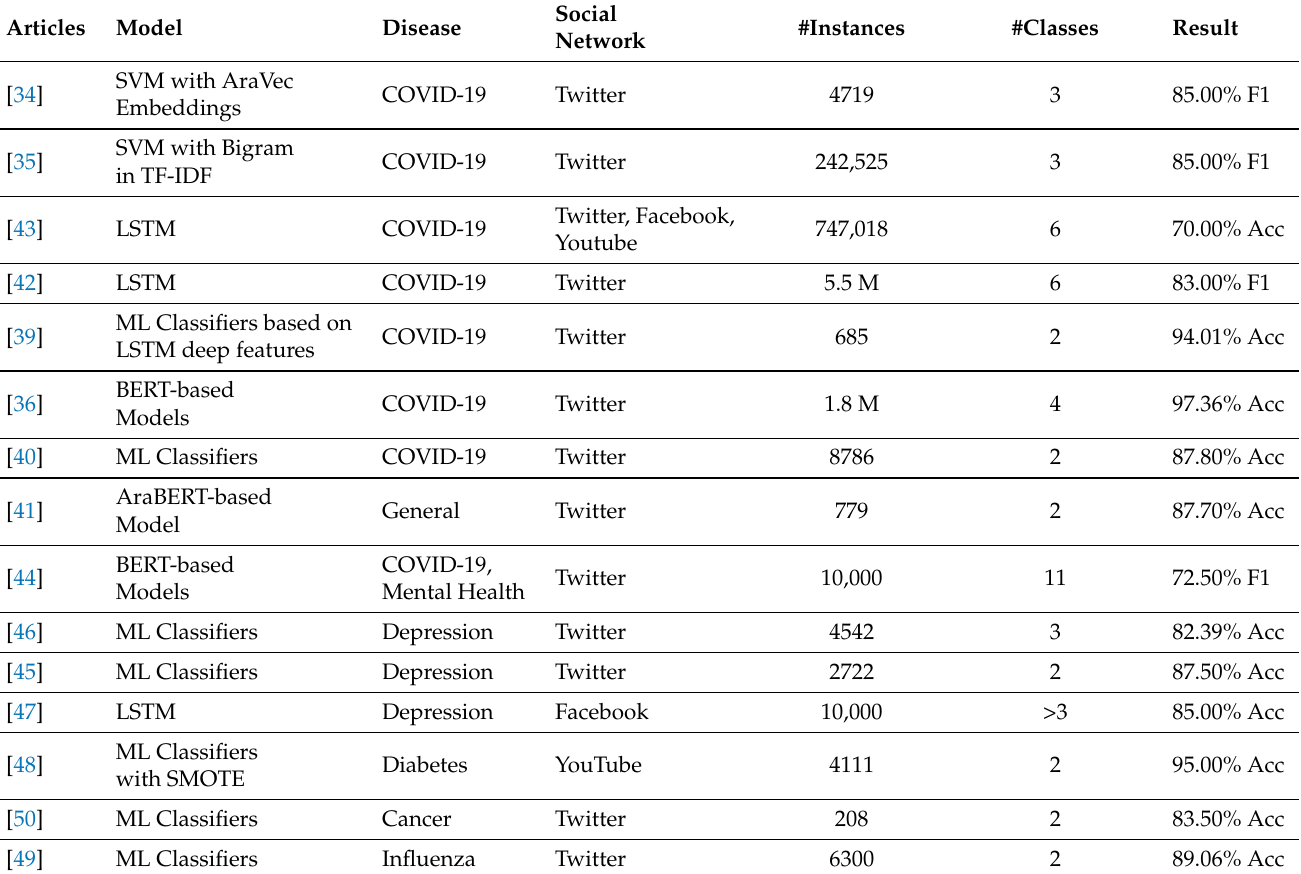
Table 1. A summary of related work for recent Arabic sentiment analysis related to public